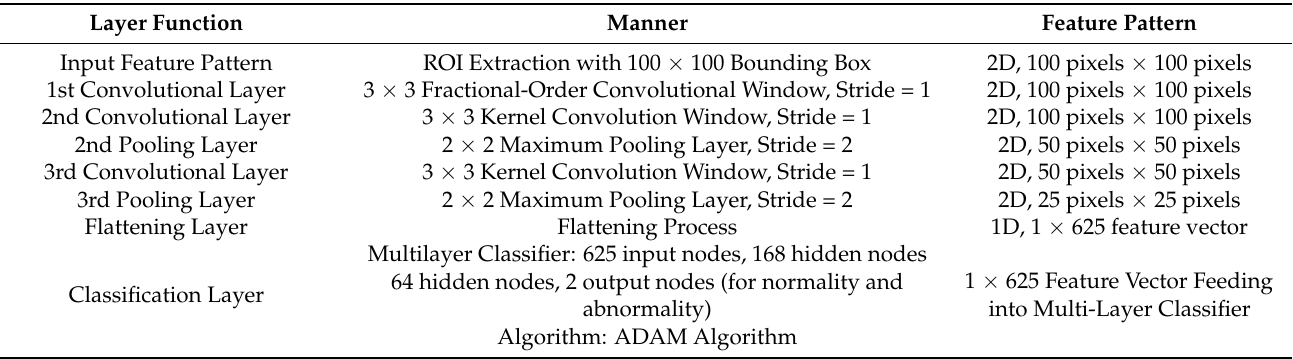
Table 1. Relevant information about the proposed multilayer